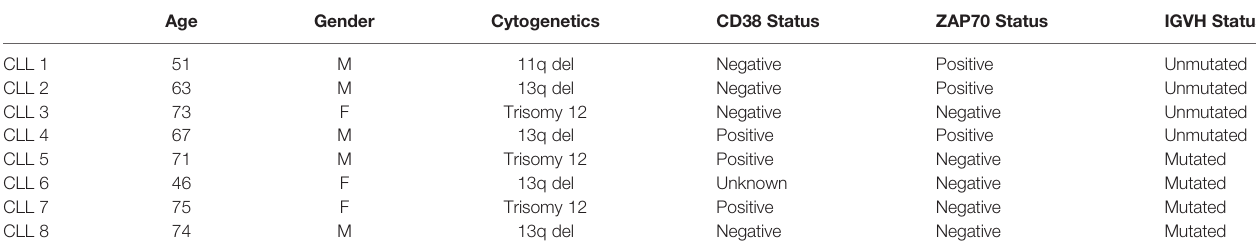
TABLE 1 | CLL patient